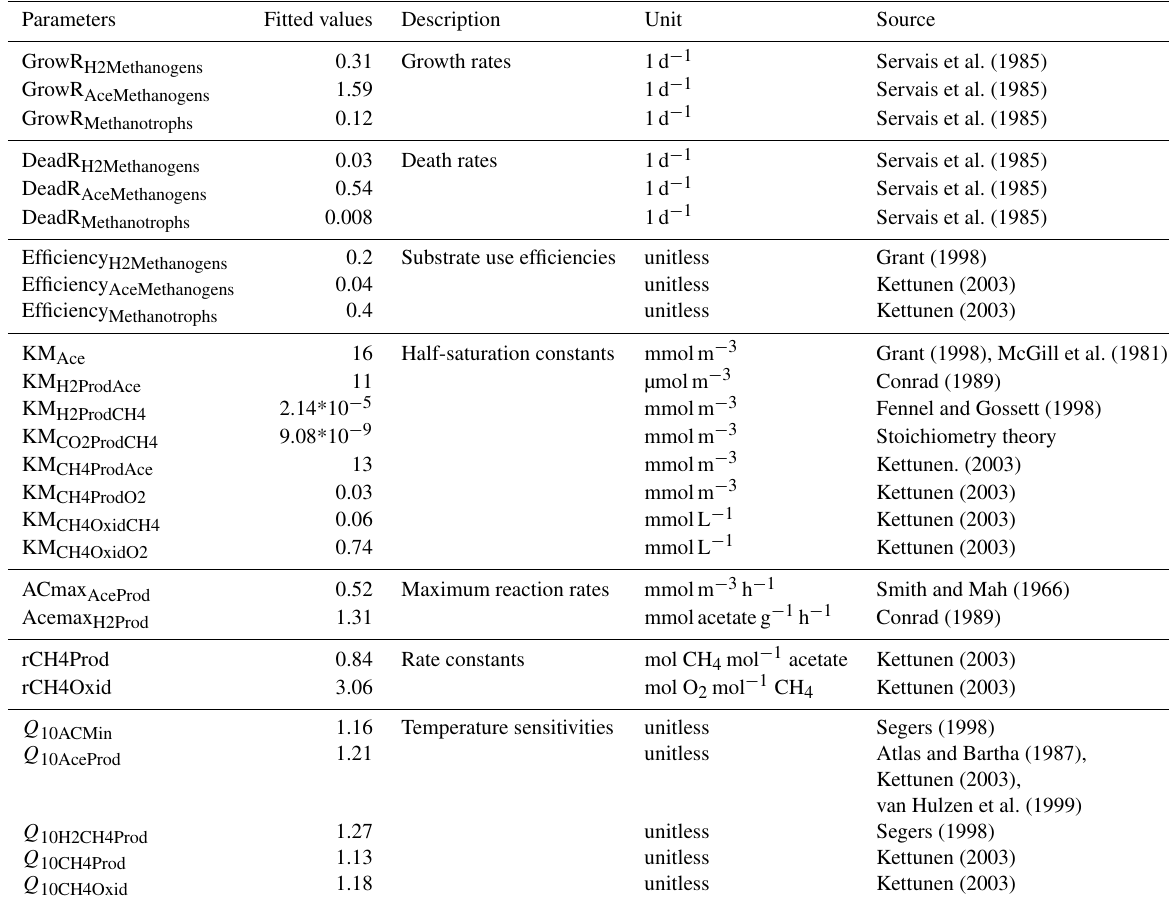
Table 1. Fitted values of M3D-DAMM model